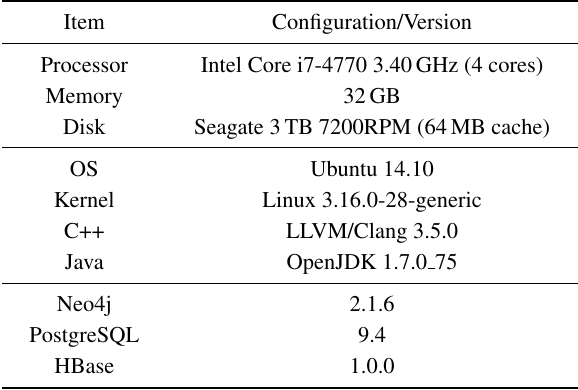
Table 2 Hardware and software configuration